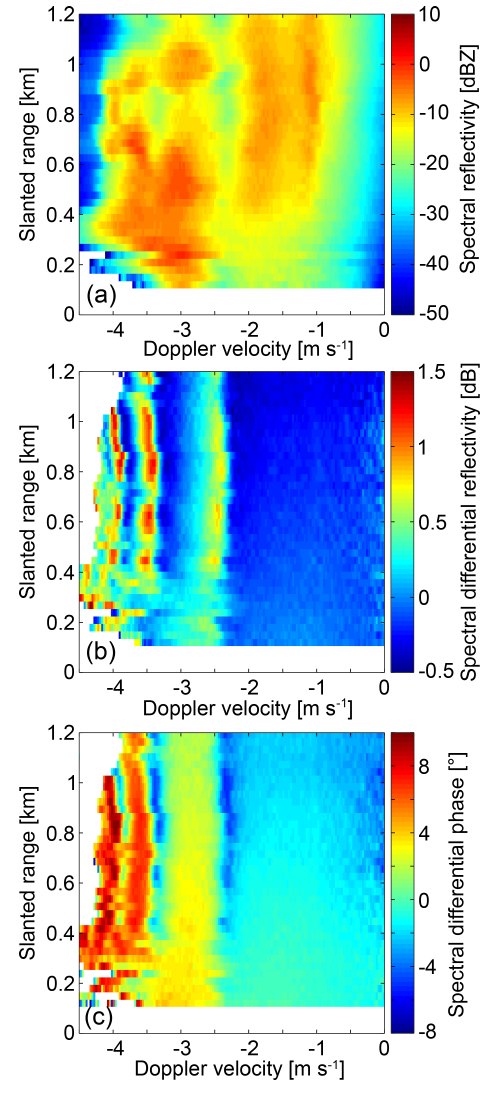
Figure 10. Range profiles of Doppler spectra of reflectivity (a) , dif- ferential reflectivity (b) , and differential phase (c) . The measure- ments were taken by radar 1 on 9 June 2018 at 21:19:23 Coordi- nated Universal Time (UTC) in Meckenheim, Germany. The radar was pointed to a 30 ◦ elevation. Negative velocities indicate move- ments towards the radar. Relatively slow (small) drops are on the right side of the spectrum profile, while the fast-falling (big) drops are on the left side. Note that, in order to make the figure easier to interpret, the horizontal wind contribution has been roughly miti- gated by shifting the rightmost detected spectral line of a spectrum to 0ms − 1